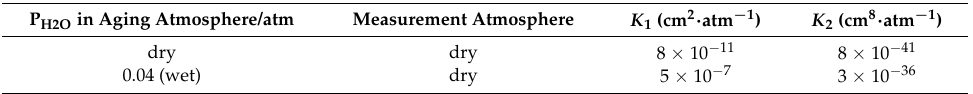
Table 1. Estimated equilibrium constants of oxygen adsorption for O − ( K 1 ) and O 2 − ( K 2 ) at 350 ◦ C in dry air. The device was aged under dry and humid